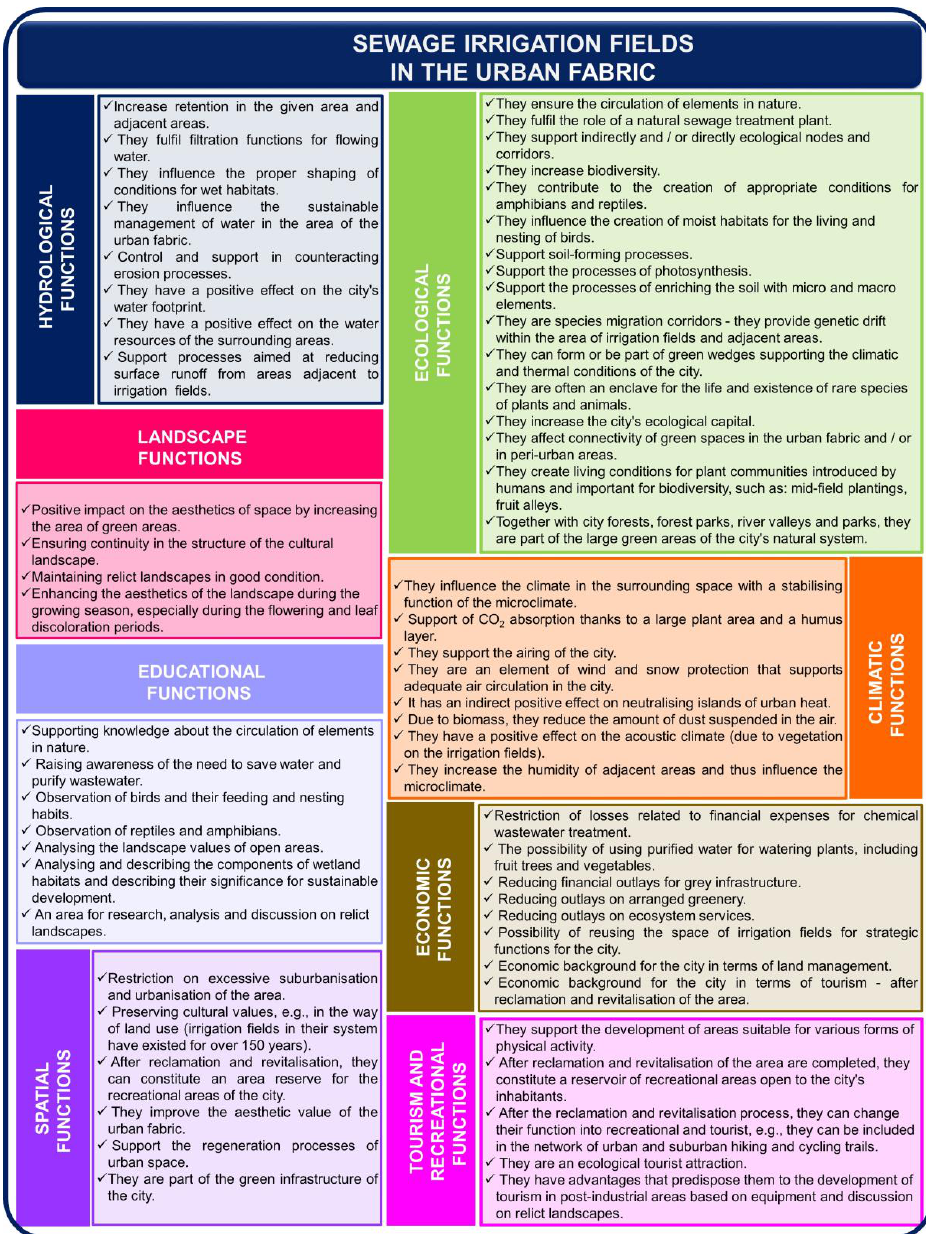
Figure 3. Functions of sewage irrigation fields in the urban tissue — multi-faceted analysis (own elaboration).